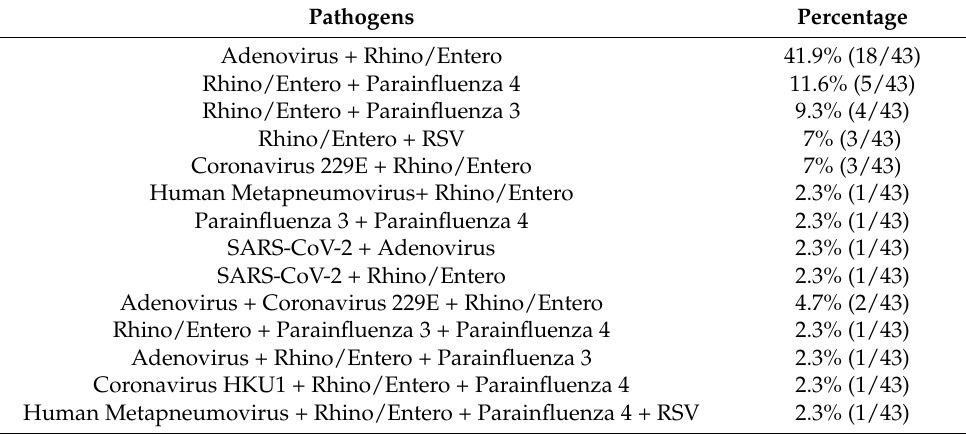
Table 1. Summary of multiorganism-positive samples.